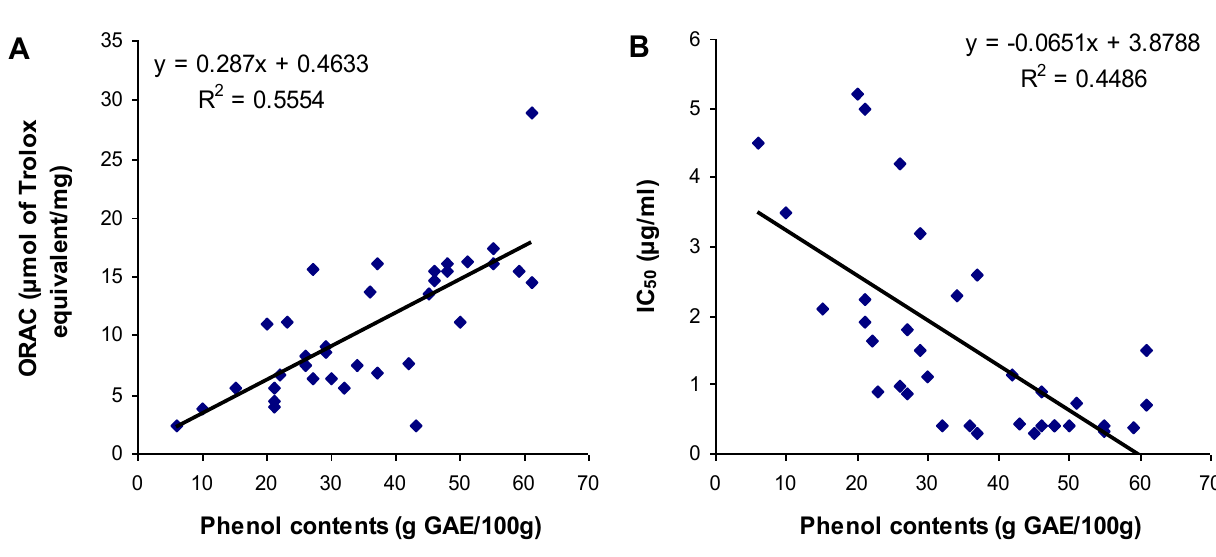
values of extracts of 50